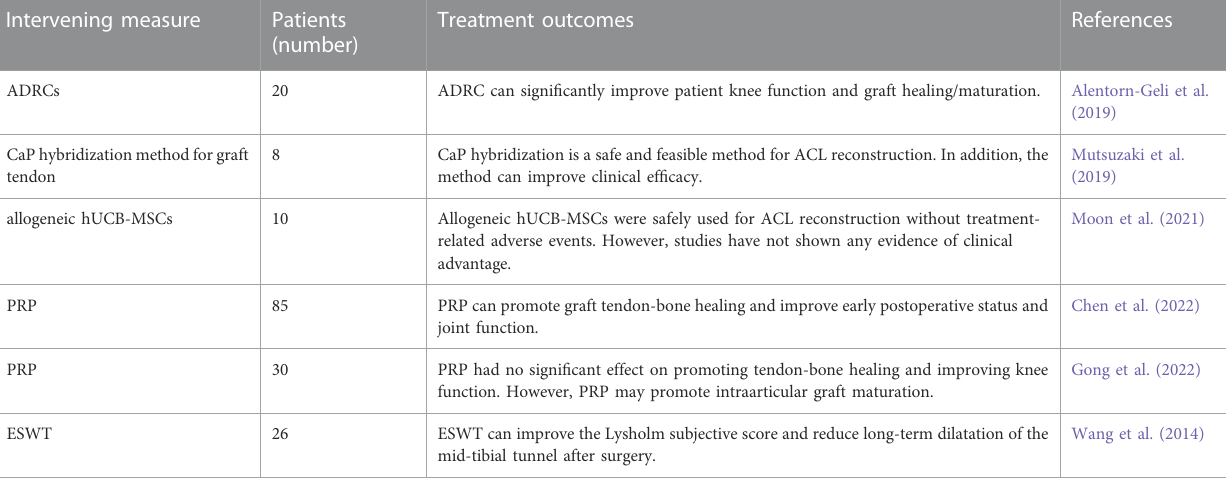
TABLE 6 Clinical studies on promoting tendon-bone healing in ACL reconstruction. Intervening